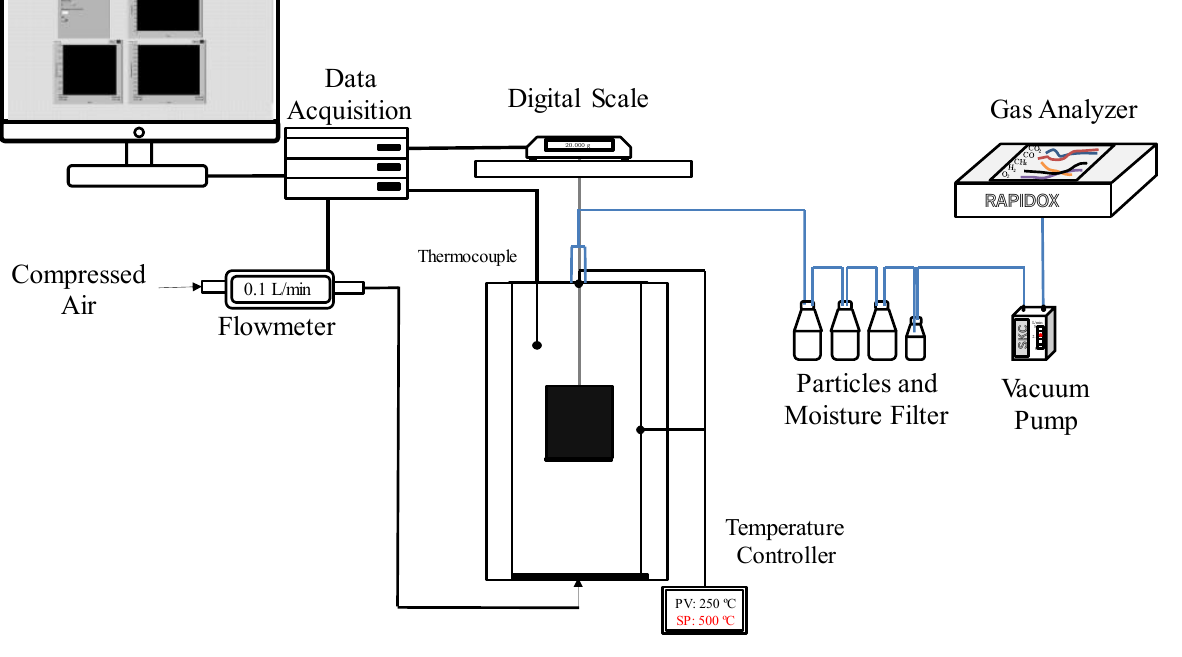
Figure 1. Experimental apparatus.